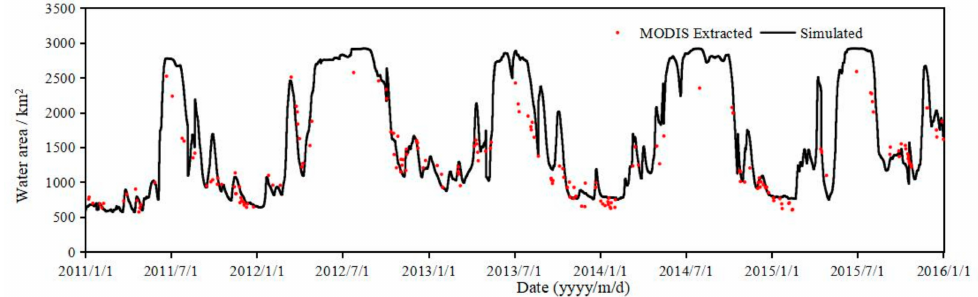
Figure 7. Comparison between MODIS extracted water areas and model simulated results.